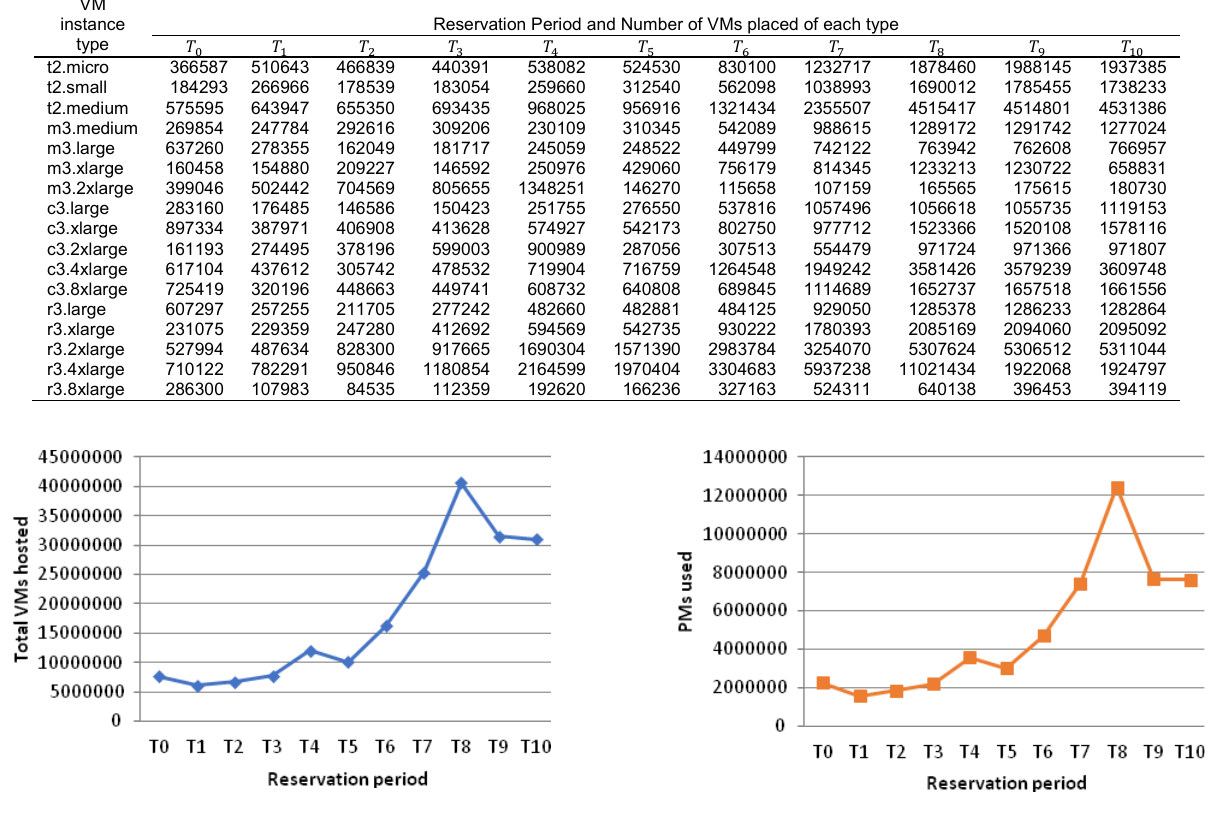
Figure 3. The outcome of BBPMM, PMs used and total VMs hosted at different reservation